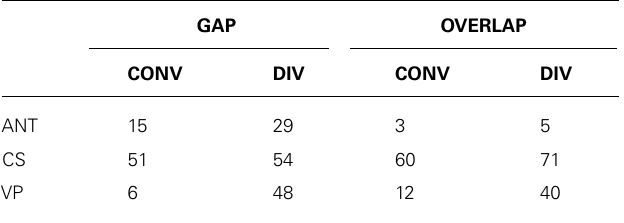
Table 1 | Percentage of rejected anticipatory movements (ANT) and of retained movements containing corrective saccades (CS) or in which the vergence component was perturbated by saccades (VP) listed per task (gap and overlap) and type of movement (CONV, convergent movements; DIV, divergent movements).